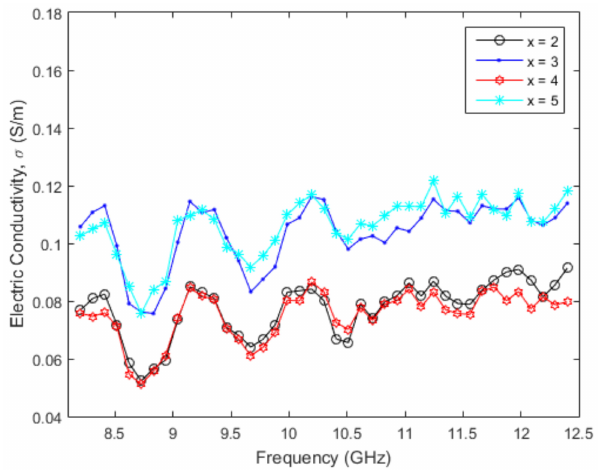
Figure 5. Frequency dependencies of electric conductivity for S r0.3 Ba 0.4 Pb 0.3 Fe 12 O 19 /(CuFe 2 O 4 ) x composite samples (x = 2, 3, 4 and 5).